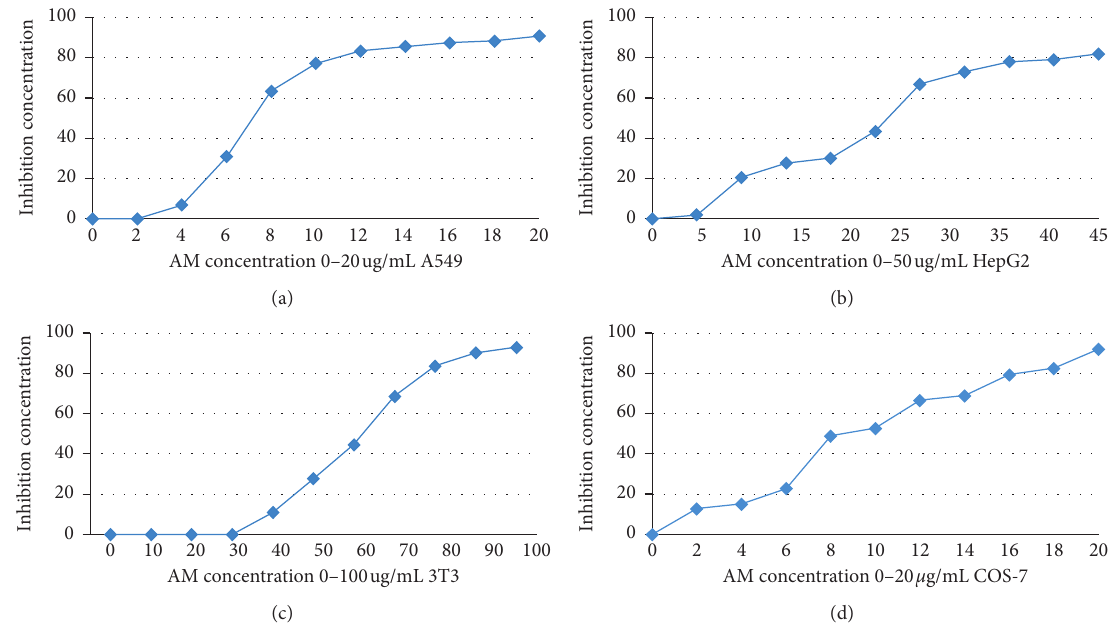
Figure 1: Dose response curve of A. malaccensis extract against different cell